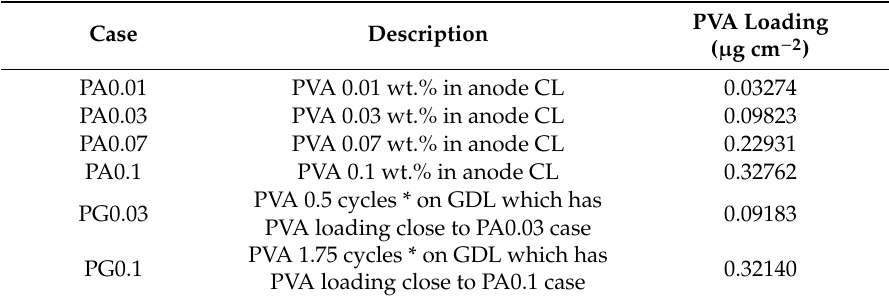
Figure 2. Performances of membrane electrode assemblies (MEAs) without PVA under non-humidified and humidified anode conditions, at a fuel cell temperature of ( a ) 60 °C and ( b ) 70 °C. Table 2. PVA-MEA